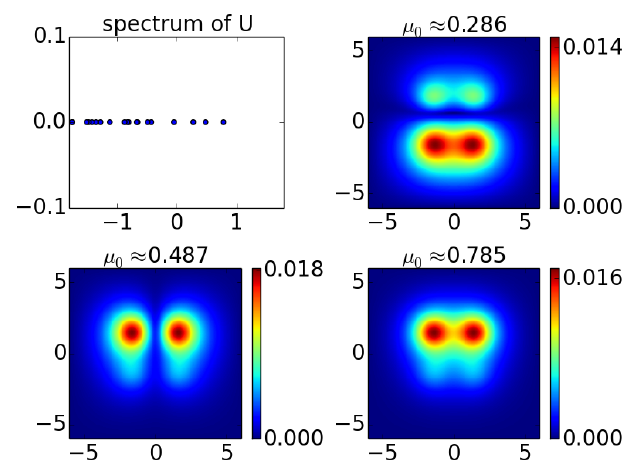
Figure 2. The top left plot shows the spectrum of Schrödinger operator associated with the potential U in the complex plane (see also the text). Plots of the magnitude of the normalized eigenvectors for the three discrete eigenvalues µ 0 are shown in the other three